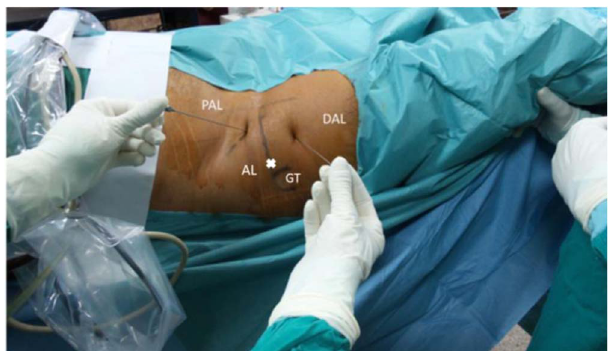
Figure 1. Standard portals used during the arthroscopic procedure. PAL: proximal anterolateral portal, DAL: distal anterolateral portal, AL: anterolateral portal, GT: greater